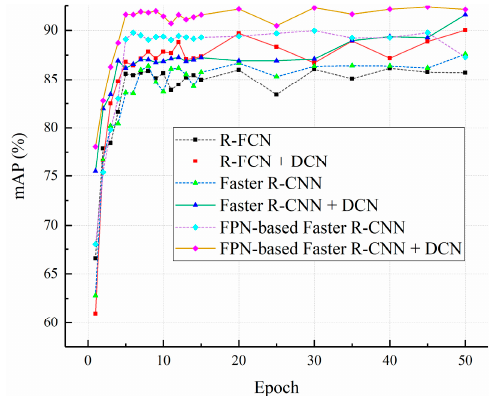
Figure 12. Mean average precisions ( mAPs) of the detectors under their optimal configurations versus the number of epochs.